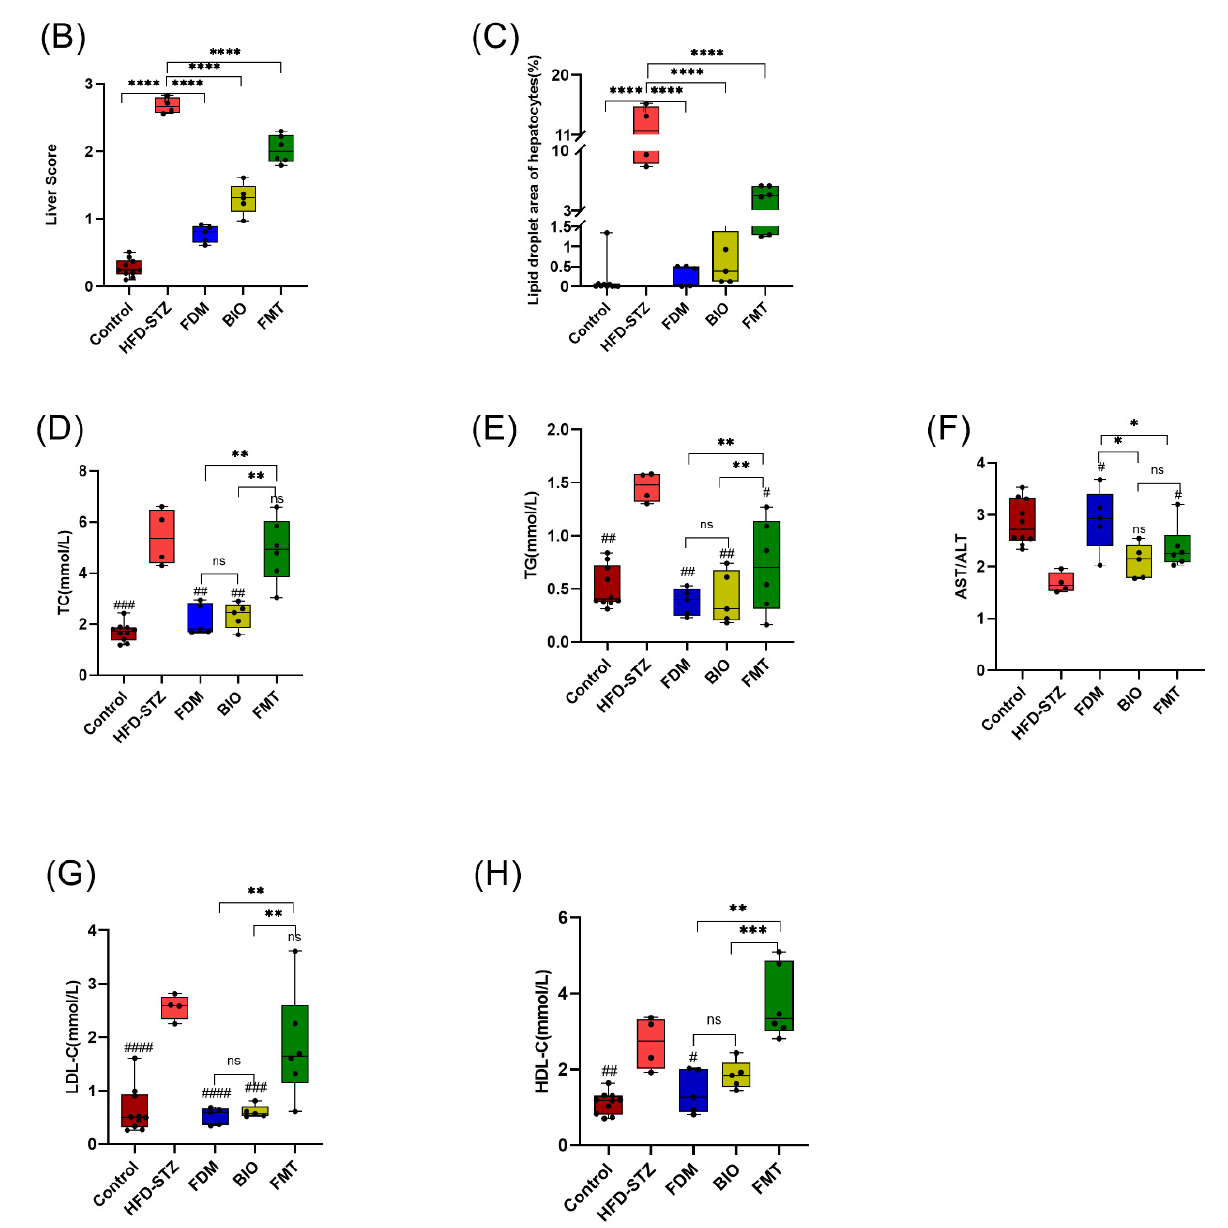
Figure 6. Effects of bacterial transplantation on fatty liver and blood lipids. ( A – C ) Images of liver tissues stained with hematoxylin and eosin (HE; 200 × ) and oil red O (200 × ). There are obvious pseudo-lobules and lipid droplets in the HFD-STZ group. The three groups receiving bacterial transplantation treatment were significantly transformed to normal liver cell tissue, of which the FDM group recovered the most notably ( p < 0.0, 001). ( D – H ) Plasma total cholesterol (TC), triglycerides (TG), aspartate aminotransferase/alanine aminotransferase (AST/ALT), low-density lipoprotein cholesterol (LDL-C), and high-density lipoprotein cholesterol (HDL-C) levels. The serum levels of TC, TG, and LDL-C in the FDM and BIO groups decreased significantly, and the HDL-C increased significantly in the FMT group. The number of mice in each group at the end of the experiment was as follows: control ( n = 10), HFD-STZ ( n = 4), FDM ( n = 5), BIO ( n = 5), and FMT ( n = 6). * ( p < 0.05), ** ( p < 0.01), *** ( p < 0.001), **** ( p < 0.0001), ns ( p > 0.05) represents the one-way ANOVA analysis with the each group, # ( p < 0.05), ## ( p < 0.01), ### ( p < 0.001), and #### ( p < 0.0001) represents the one-way ANOVA analysis with the HFD-STZ